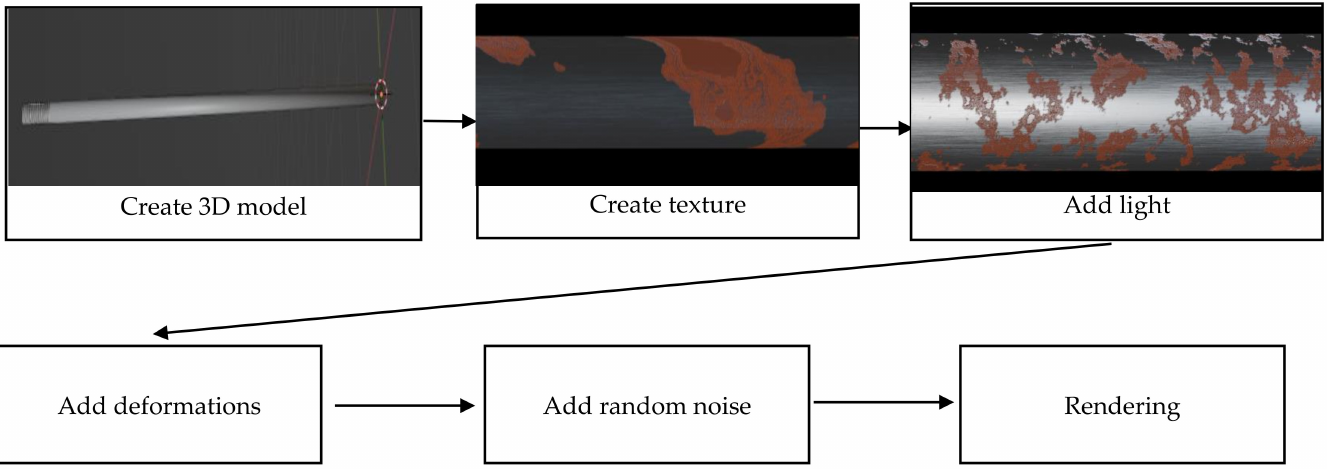
Figure 3. Blender shading